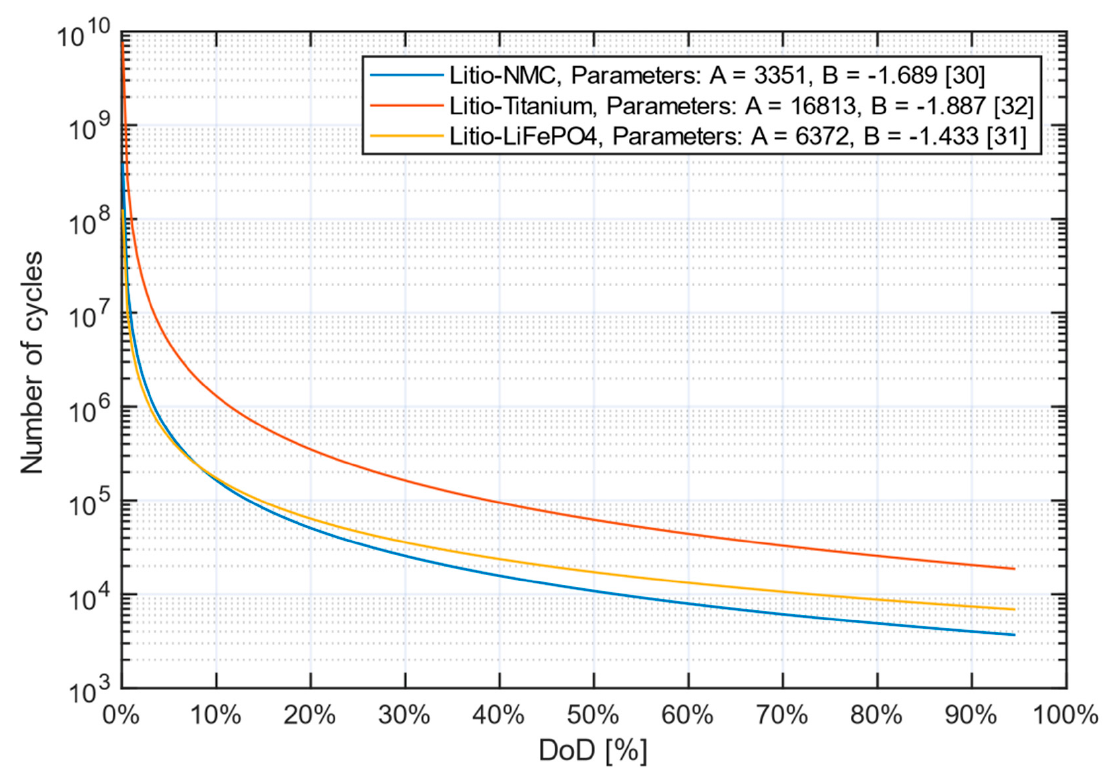
Figure 3. Number of cycles versus DoD for different lithium technologies.